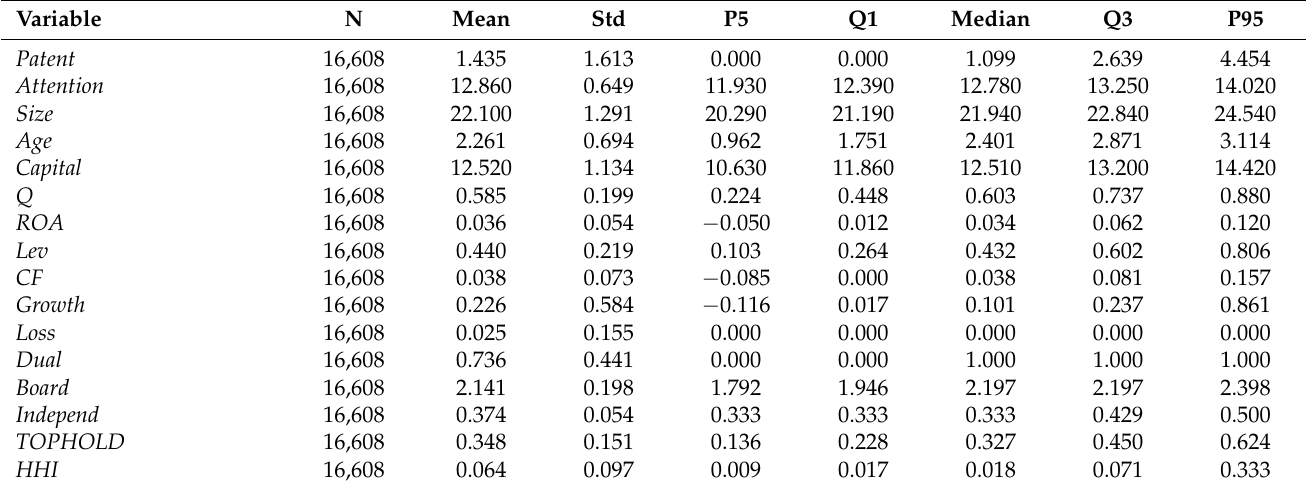
Table 1. Summary statistics.